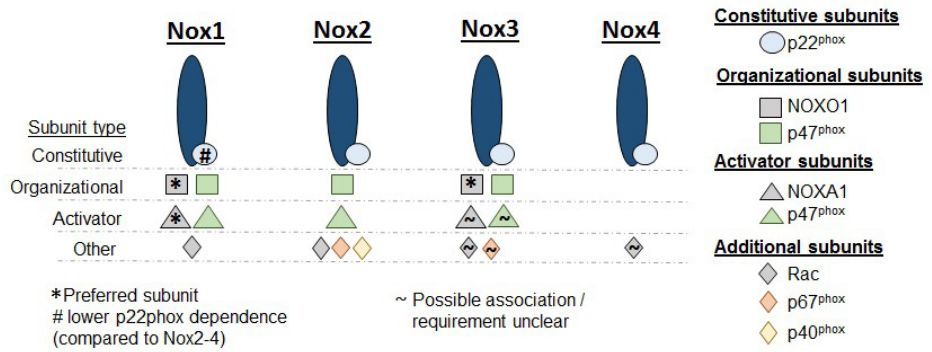
Figure 1. Nox isoforms and subunits. Diagram showing subunit requirements for the isoforms 1–4 of NADPH oxidase (Nox). In addition to the base Nox enzyme, p22 phox is constitutively required across Nox1–4. While Nox4 does not require any further subunits before ROS generation can